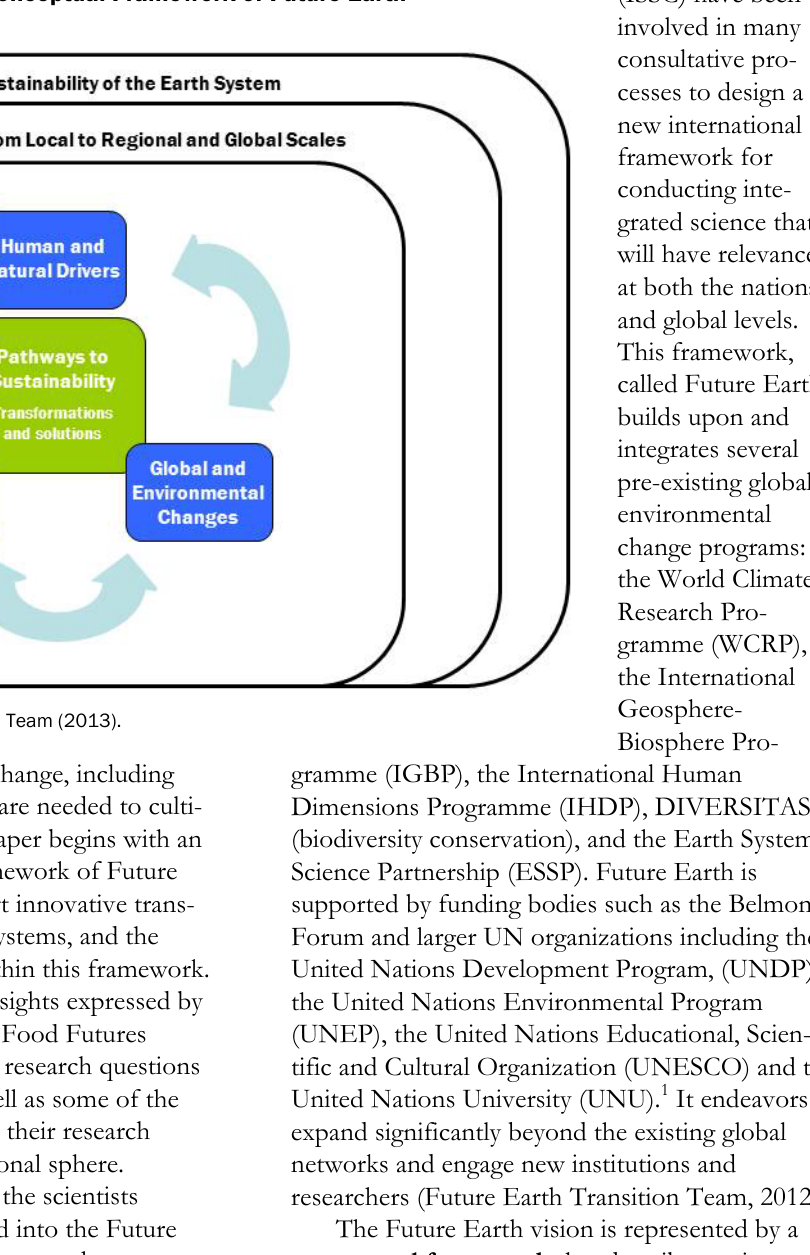
Figure 1. Schematic of the Conceptual Framework of Future